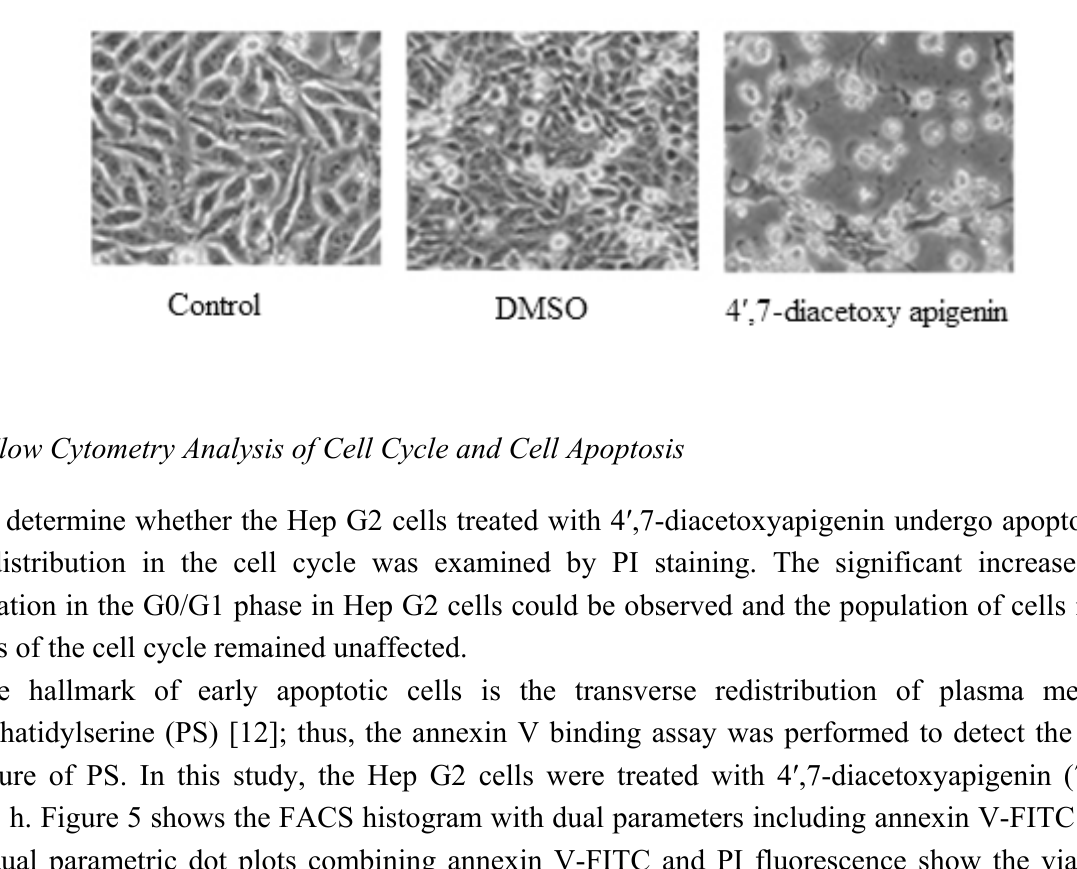
Figure 3. Morphology of Hep G2 cells treated by 4 ′ ,7-diacetoxyapigenin (70 μ M, 48